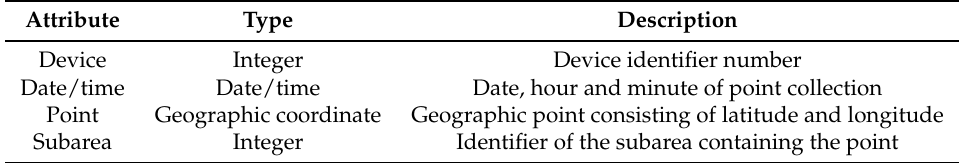
Algorithm 1.1 generates a list of points with their respective subareas to be processed in parallel by Algorithm 1.2. Such a structure is detailed in Table 6. Table 6. Groups and risks: Algorithm 3 (detection of risks)